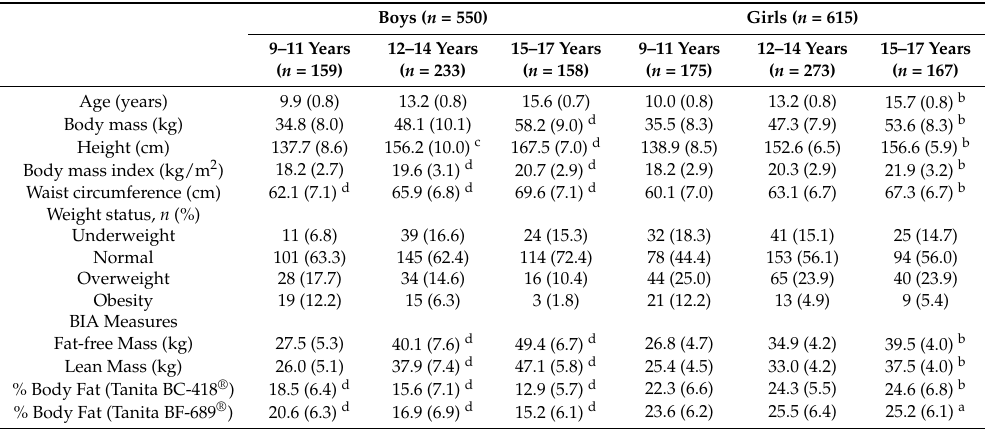
Table 1. Characteristics of school children by sex and age.